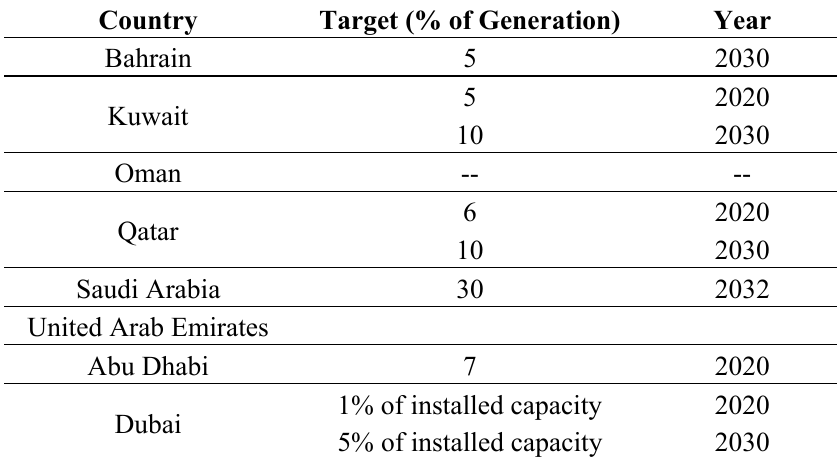
Table 2. Renewable electricity targets for the GCC countries. Source: